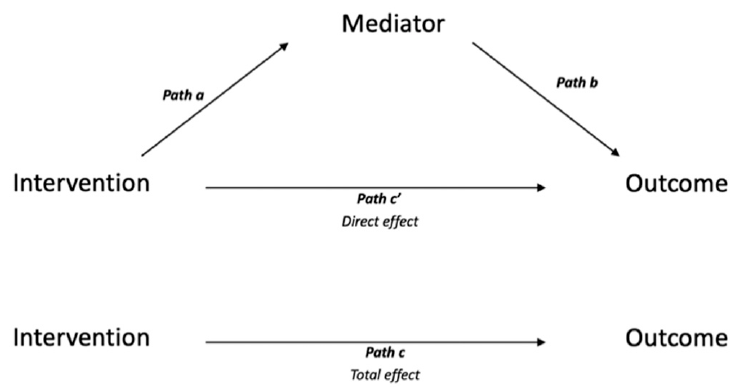
Figure 1. Single mediator model.